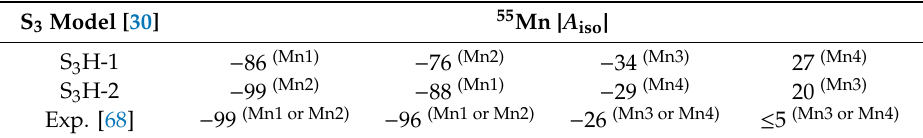
Table 1. Calculated projected 55 Mn isotropic hyperfine coupling constants (MHz) for two selected S 3 models of the type shown in Figure 4, among the several models evaluated by Krewald et al. [30], compared to experimental values for the S 3 state ordered from high to low in terms of absolute values. Superscripts in parentheses indicate assignments to individual Mn ions. Positive sign for the HFC identifies the Mn ion with minority ( β ) spin. The two models listed here di ff er in the presence (model “S 3 H-1”) or absence (“S 3 H-2”) of direct hydrogen bonding between O5 and the Mn1-bound O6H